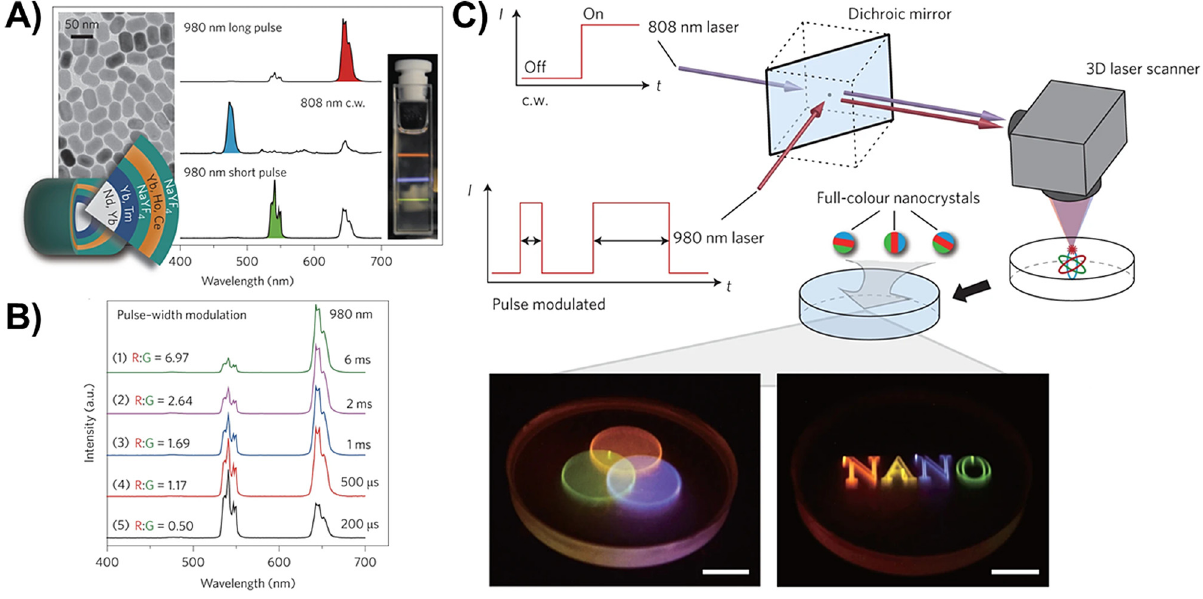
Figure 6: (A) Schematic and Transmission Electron Microscope (TEM) image of a NaYF 4 -based core-shell nanocrystal (NC) capable of